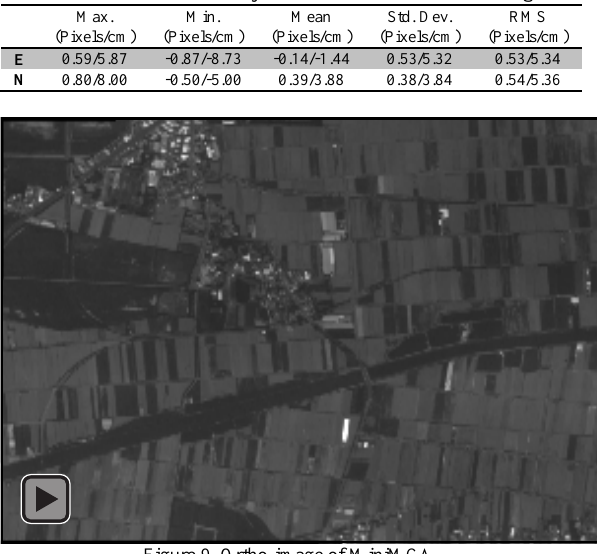
Table 4. Error analyses of Canon RGB ortho image Max.